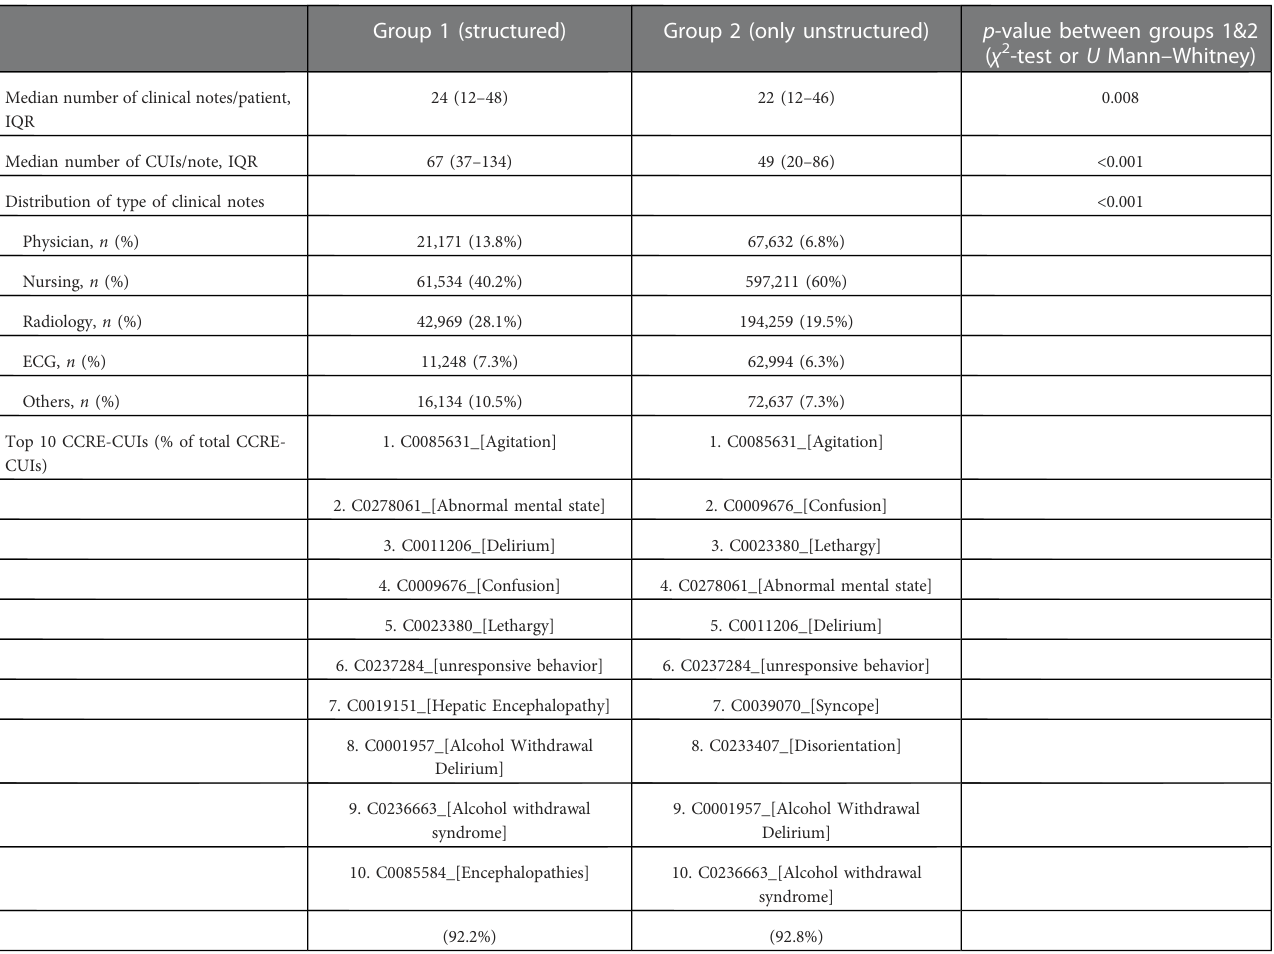
TABLE 3 Comparison of text features between structured and unstructured cohorts.